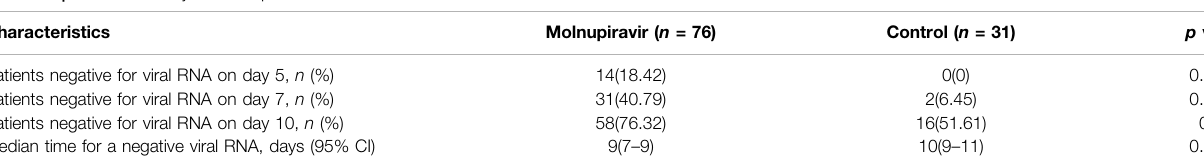
TABLE 2 | Antiviral ef fi cacy of molnupiravir. Characteristics